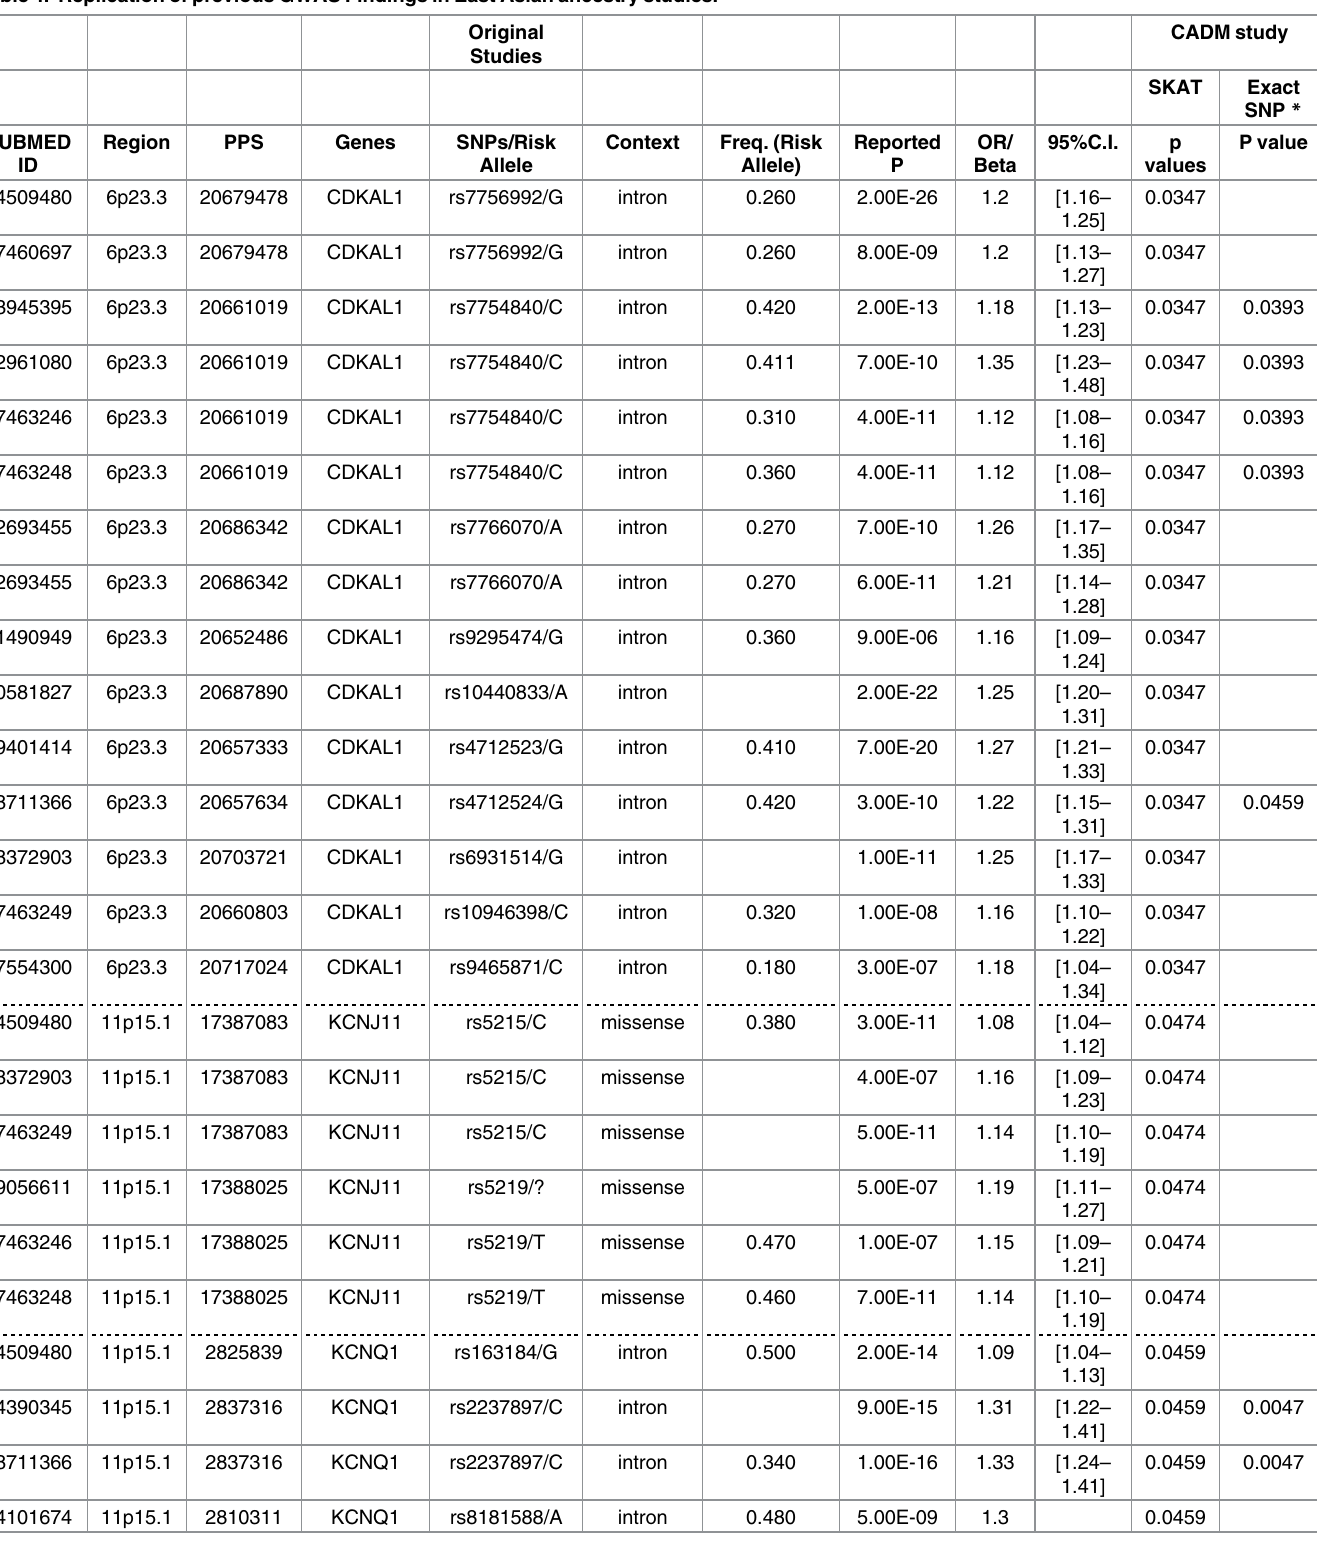
Table 4. Replication of previous GWAS Findings in East Asian ancestry